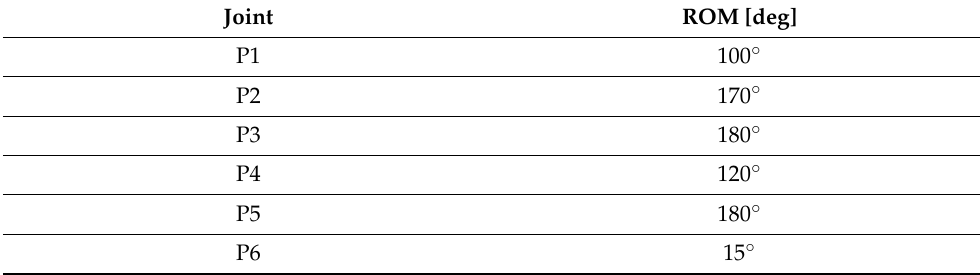
Table 5. Range of motion of the passive polyarticulated